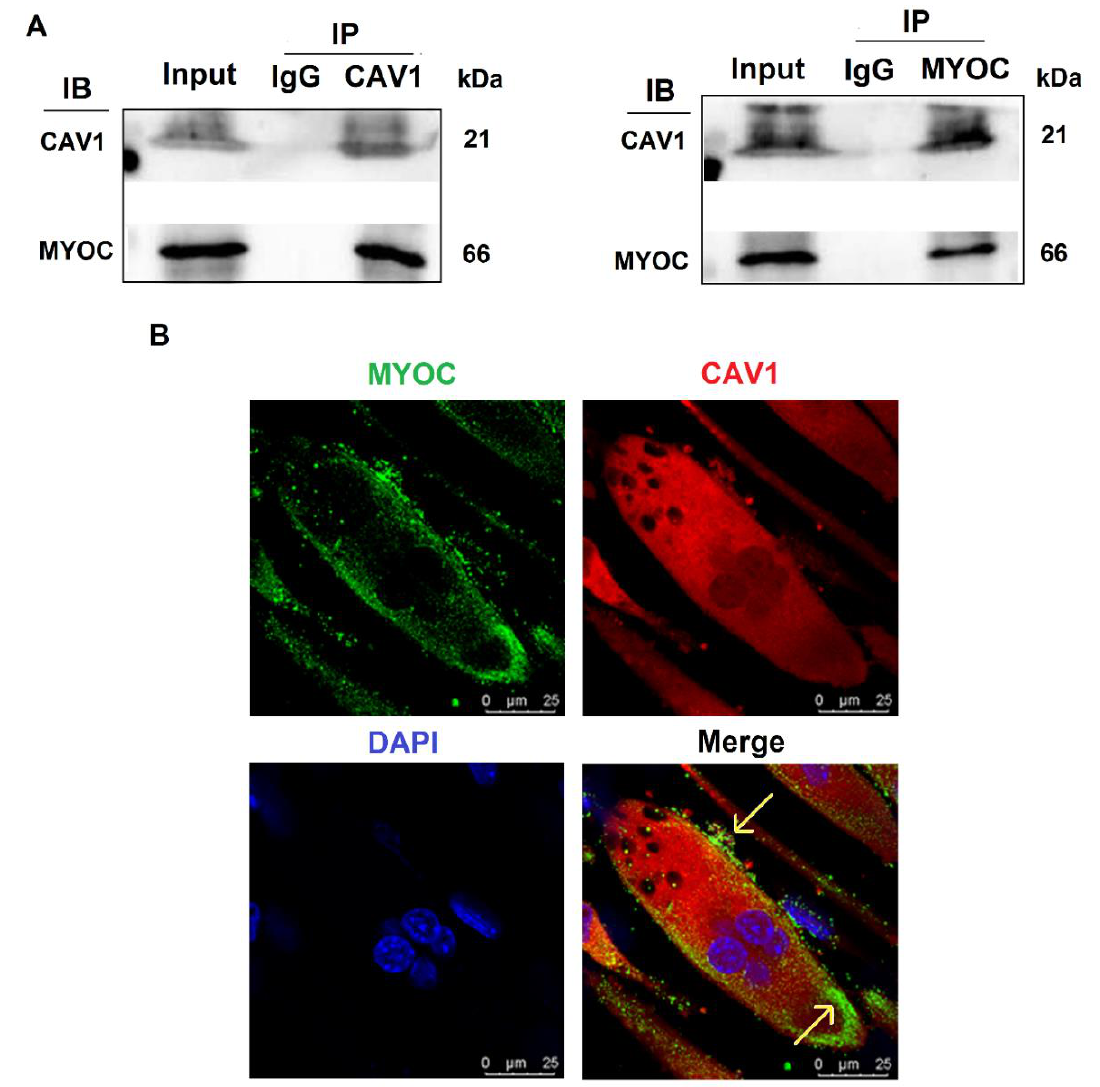
Figure 3. Interaction and localization of MYOC and CAV1. ( A ). MYOC and CAV1 antibodies were used for coprecipitation respectively, each able to be precipitated. ( B ). Location of MYOC and CAV1 in highly differentiated C2C12 cells as observed using laser confocal microscopy. MYOC was labeled as green using FITC-488, CAV1 was labeled red using RBFITC, and the nucleus was stained blue using DAPI.